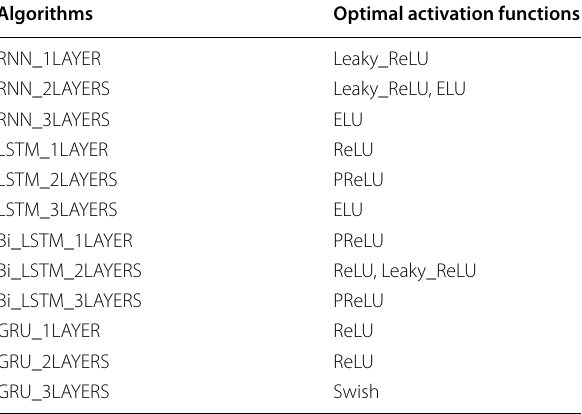
Table 4 Optimal activation functions for different algorithms Algorithms Optimal activation functions